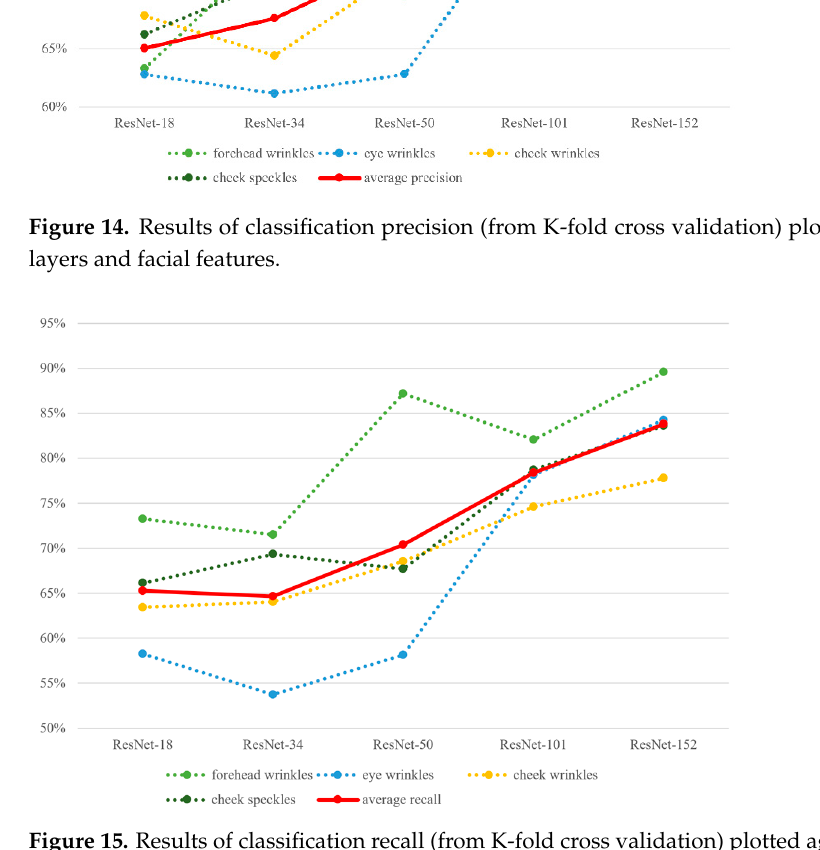
Figure 15. Results of classification recall (from K-fold cross validation) plotted against model layers and facial